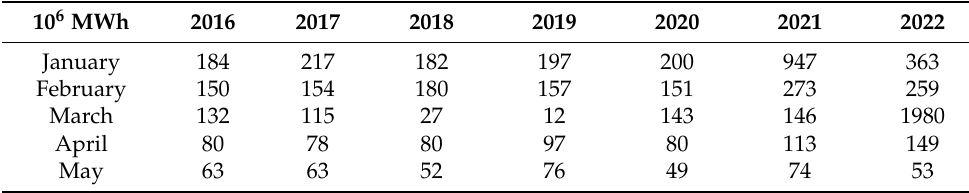
Table 6. Italy/Switzerland. Exit